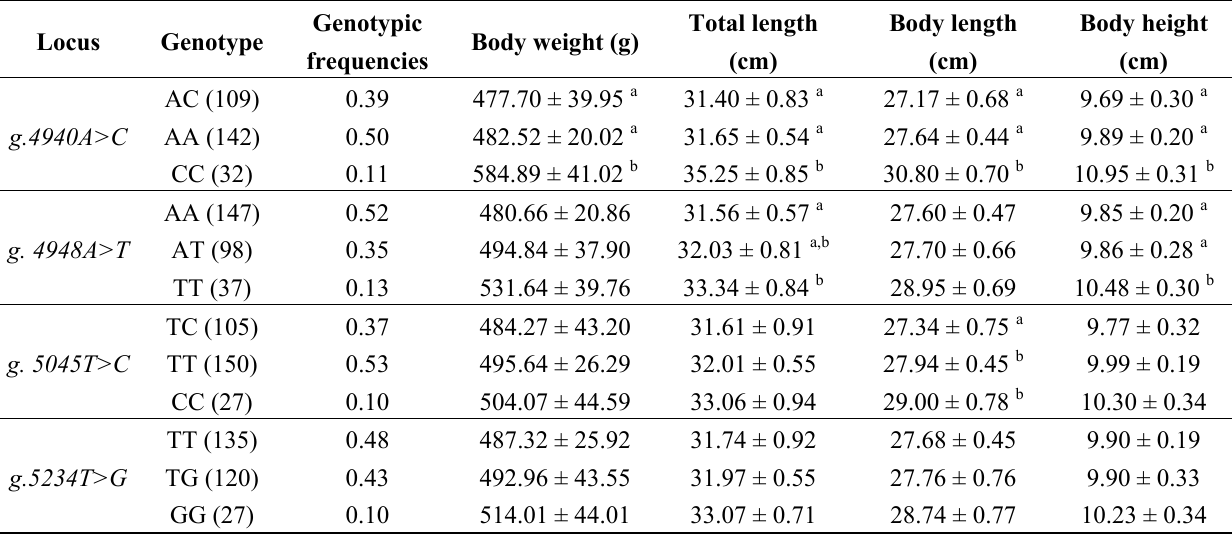
Table 2. Association between four polymorphic SNP sites of GH gene and growth traits in S. chuatsi . Locus